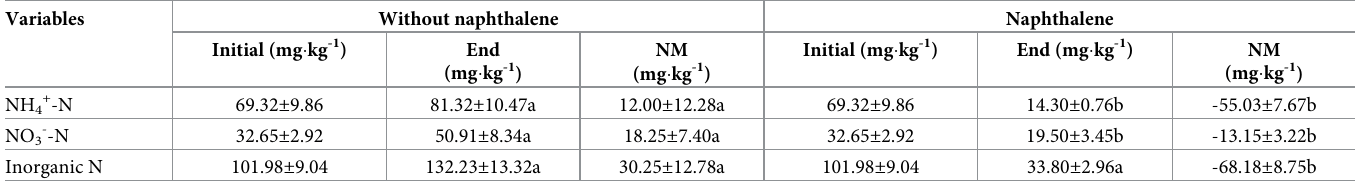
NM, net mineralization rate. The nitrogen content is based on the analysis of five individual microcosms from each treatment before and after 52 days. The values represent the means ± the standard error SE (n = 5). Letters indicate significant differences ( P < 0.05) based on Student’s t-test